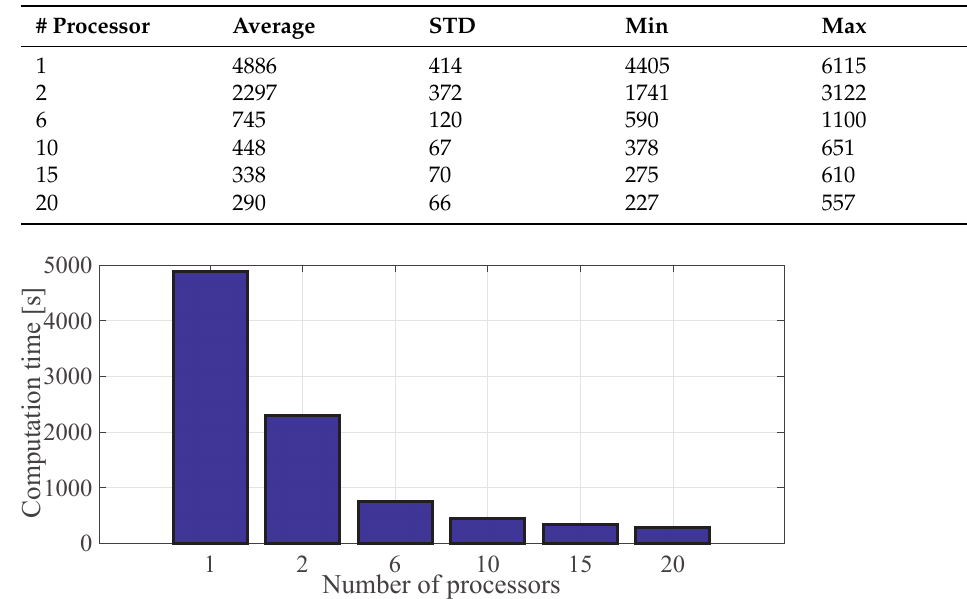
Table 2. Computation time statistics for each scenario.